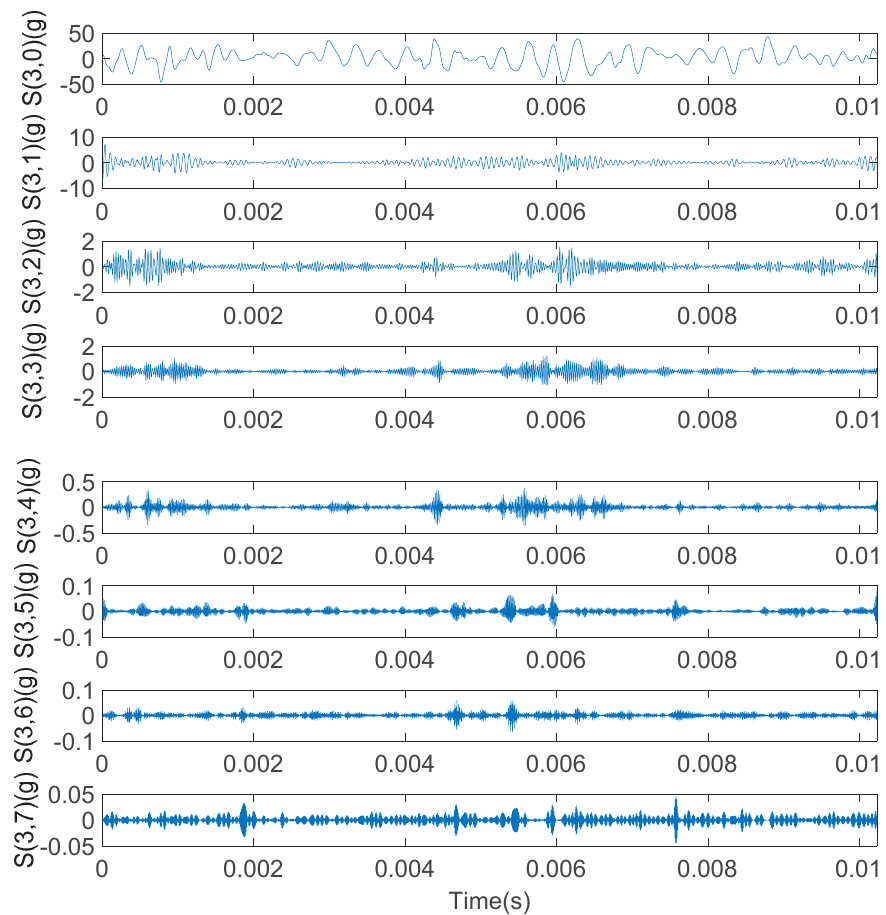
Figure 22. Frequency characteristics of reconstructed signals of node S (3,0). 7. Conclusions In this paper, the IMFE method is used to extract the knock characteristic frequency of engine block vibration signals of a two-stroke SI UAV engine burning RP-3 kerosene fuel under a weak knock condition. In this way, engine block vibration signals are decomposed into a series of IMF components in the frequency domain adaptively. Calculate the energy weight value of each IMF component, and select the component with the largest energy weight value as the dominant characteristic component. By analyzing the spectral characteristics of the main IMF component, the knock characteristic frequency of the vibration signal can be obtained. The results show that the weak knock characteristic frequencies of the engine block vibration signal at 5100 rpm and 5200 rpm are 3.320 kHz and 3.125 kHz, respectively. A Wavelet Packet Energy method is used to extract the characteristics of the engine block vibration signal of the two-stroke SI UAV engine at 5200 rpm, and the same results are obtained with the IMFE method. This verifies the effectiveness of the IMFE method in extracting the characteristic